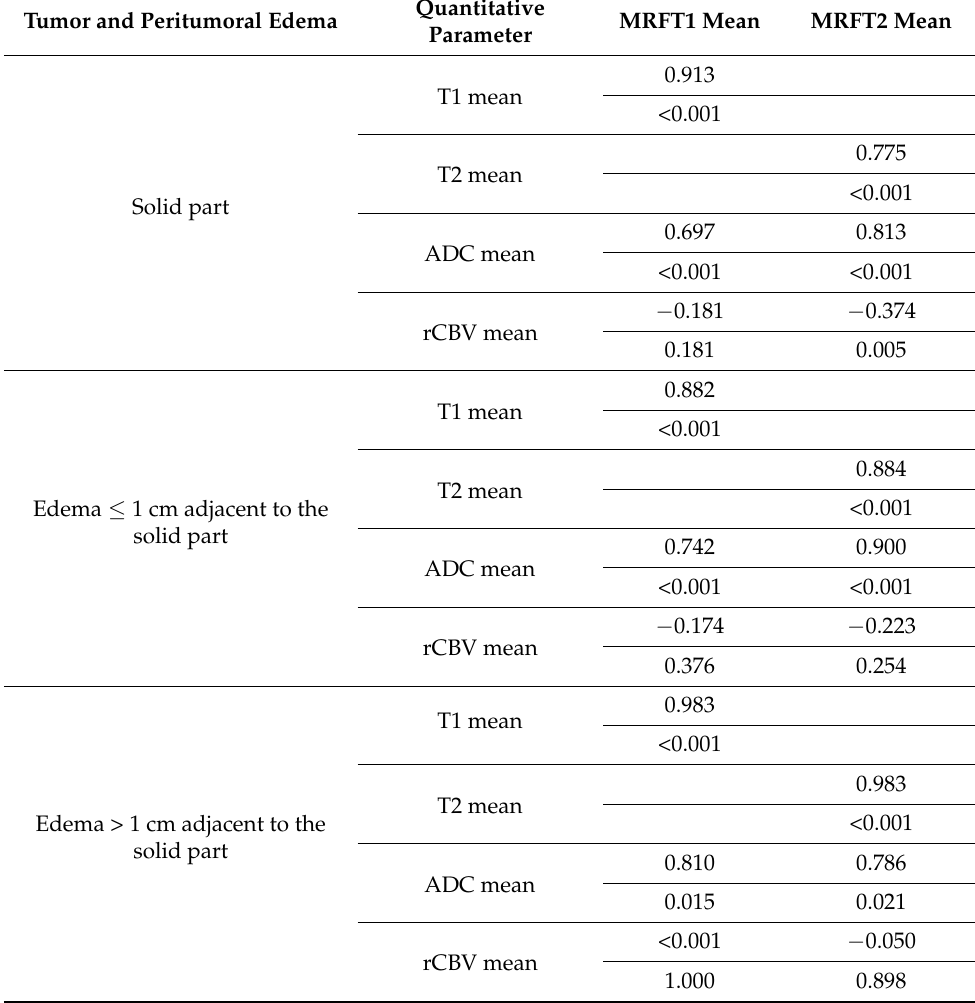
Table 4. Tumor and peritumoral